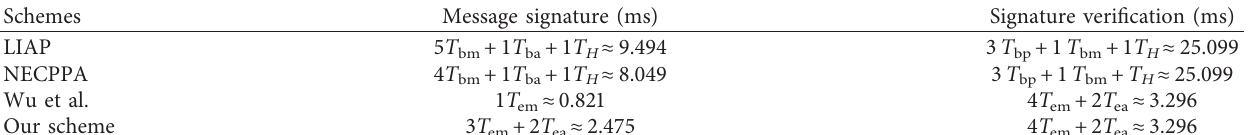
Table 4: Computation cost of signature and verification of single message for various schemes.